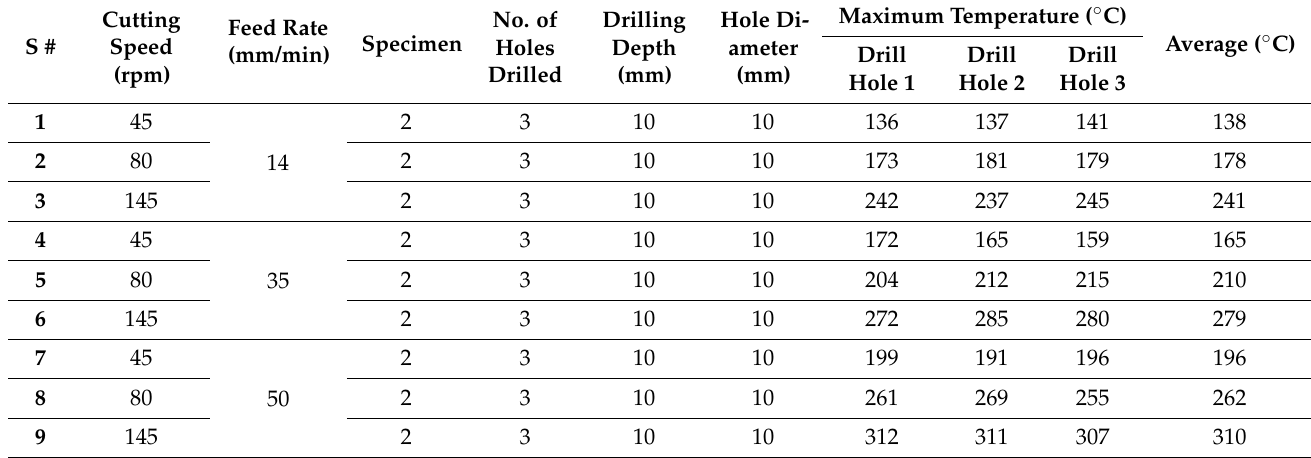
Table 7. Drilling parameters and results of maximum temperature rise during dry-drilling for each set of cutting conditions.